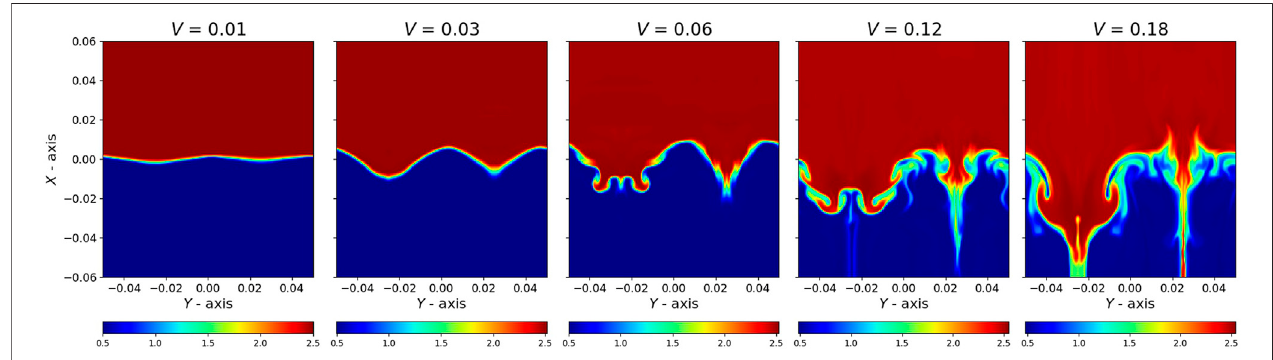
FIGURE 1 | Cross-section of density variation at z (cid:1) 0.5. Plots taken after four driver period for different velocity amplitudes ( V (cid:1) 0.01, 0.03, 0.06, 0.12, 0.18). In all simulations ζ (cid:1) 5.